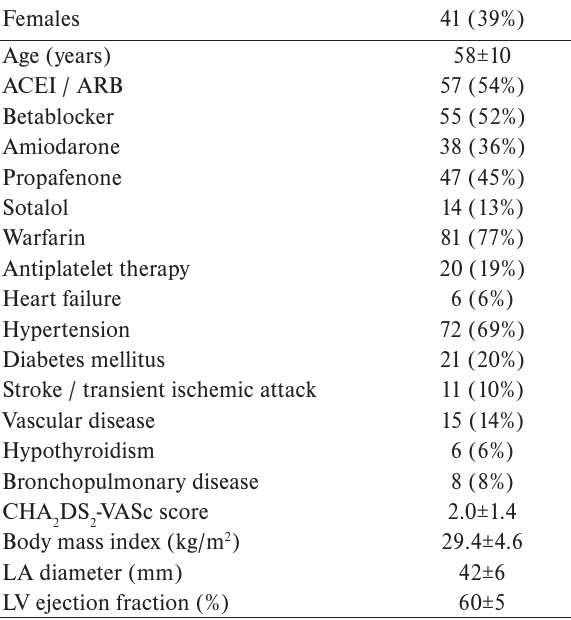
Table 1. Baseline